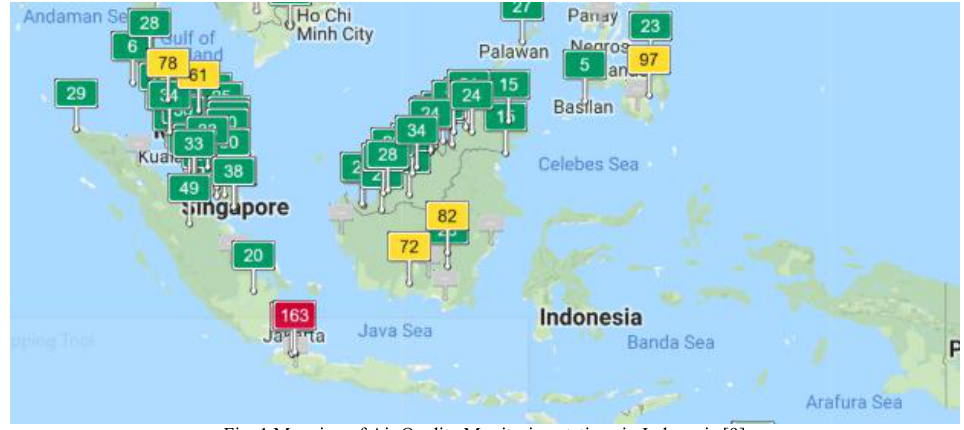
Fig. 1 Mapping of Air Quality Monitoring stations in Indonesia